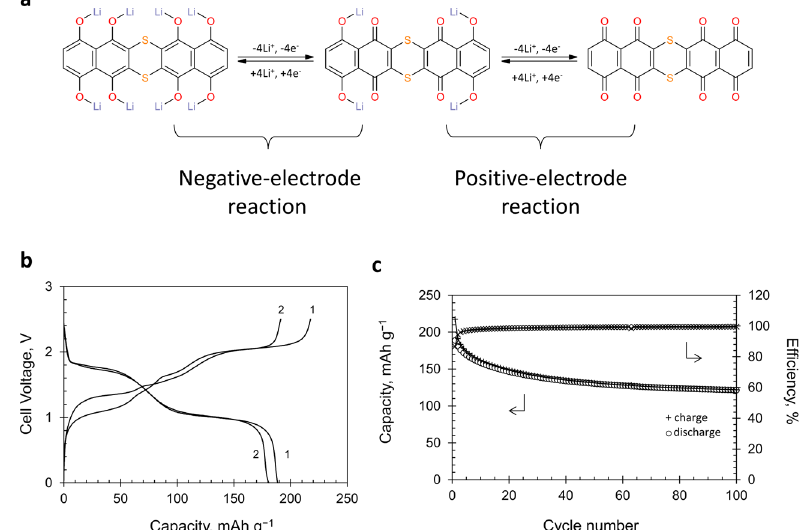
Fig. 6 Charge/discharge behavior of the symmetric full cell using 2 as both the positive and negative electrodes. a Redox reaction of 2 in both electrodes. b Charge/discharge curves of the full cell. c Cycle-life performance of the full